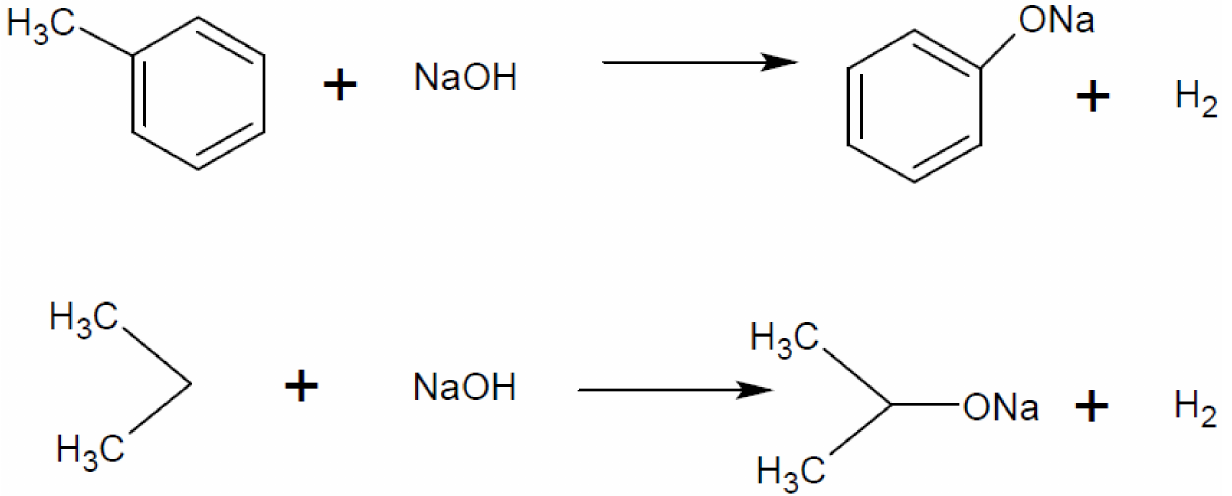
Figure 6. Examples of reactions of structural parts with potassium hydroxide, leading to modification of the structure during the chemical activation